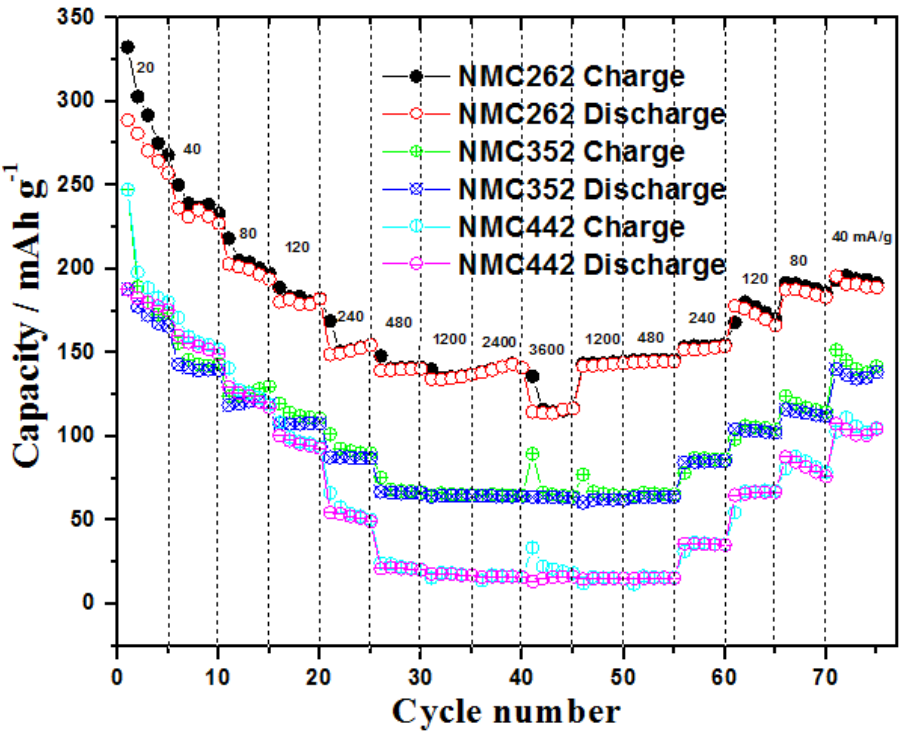
Figure 6. C-rate test of NMC262, NMC352 and NMC442 cathode materials in the voltage range of 2.0–4.7 V with current densities of 20, 40, 80, 120, 240, 480, 1200, 2400, and 3600 mA g − 1 , respectively.